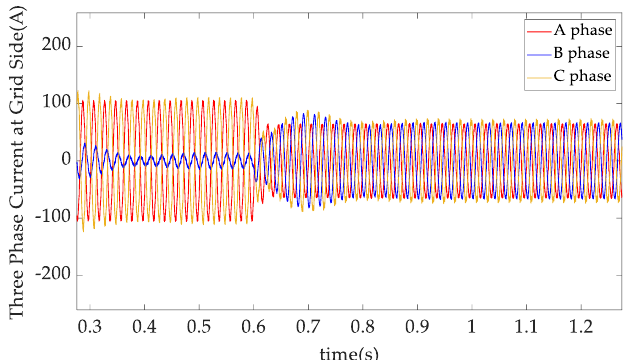
Figure 22. Primary side current waveforms before and after the VSG control adopted.